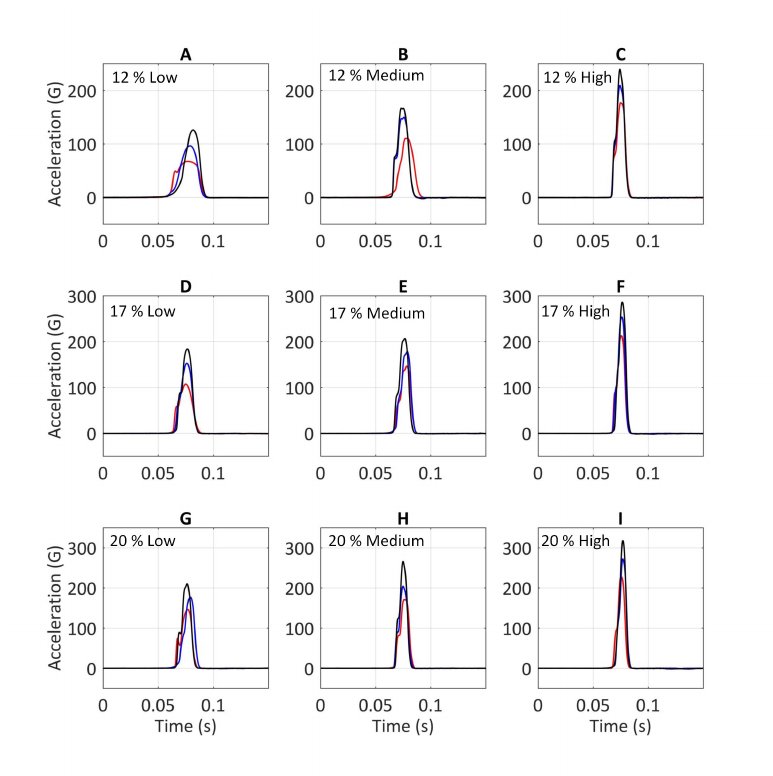
Figure 6. The G max versus time of the sand samples with different moisture levels and rates of compaction. The red, blue and black lines represent the drop height of 400 mm, 500 mm and 600 mm,